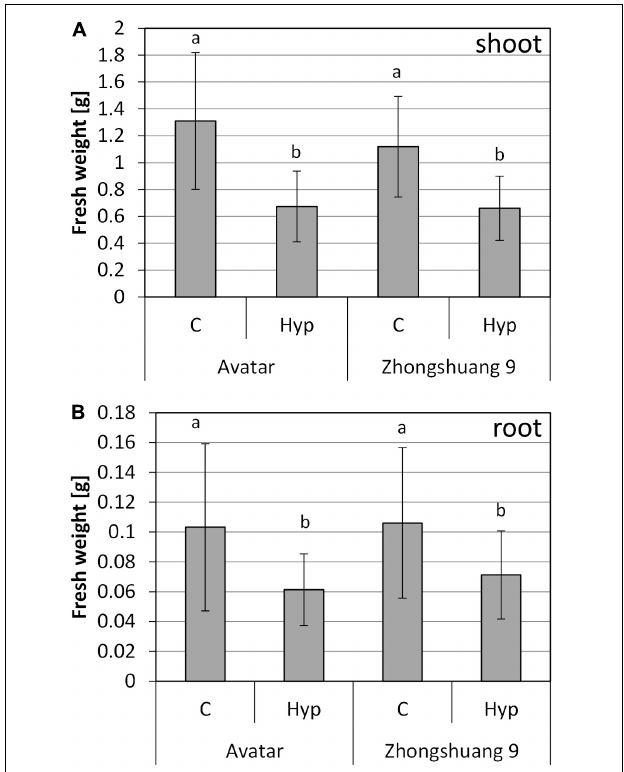
FIGURE 5 | Fresh weight of shoots (A) and roots (B) of two Brassica napus cultivars (Avatar, Zhongshuang 9) in hydroponics after 7 days of root hypoxia, compared with aerated controls. At time of harvest, plants were 22 days old. Data are means ± SD of 4 experiments with 7-10 plants per experiment ( n = 34 – 40). Different letters indicate significant differences (ANOVA and Tukey post hoc test, p <